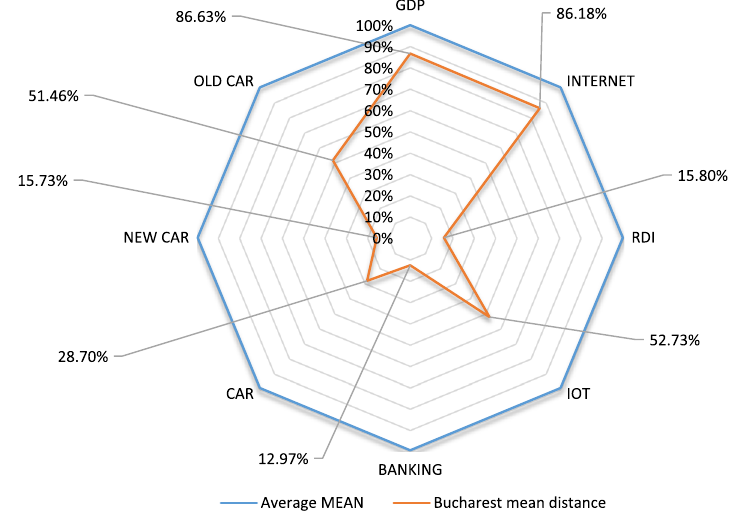
Fig. 4 Presentation of the smart development at the evaluation date for the anti‑pole of the model: the city of